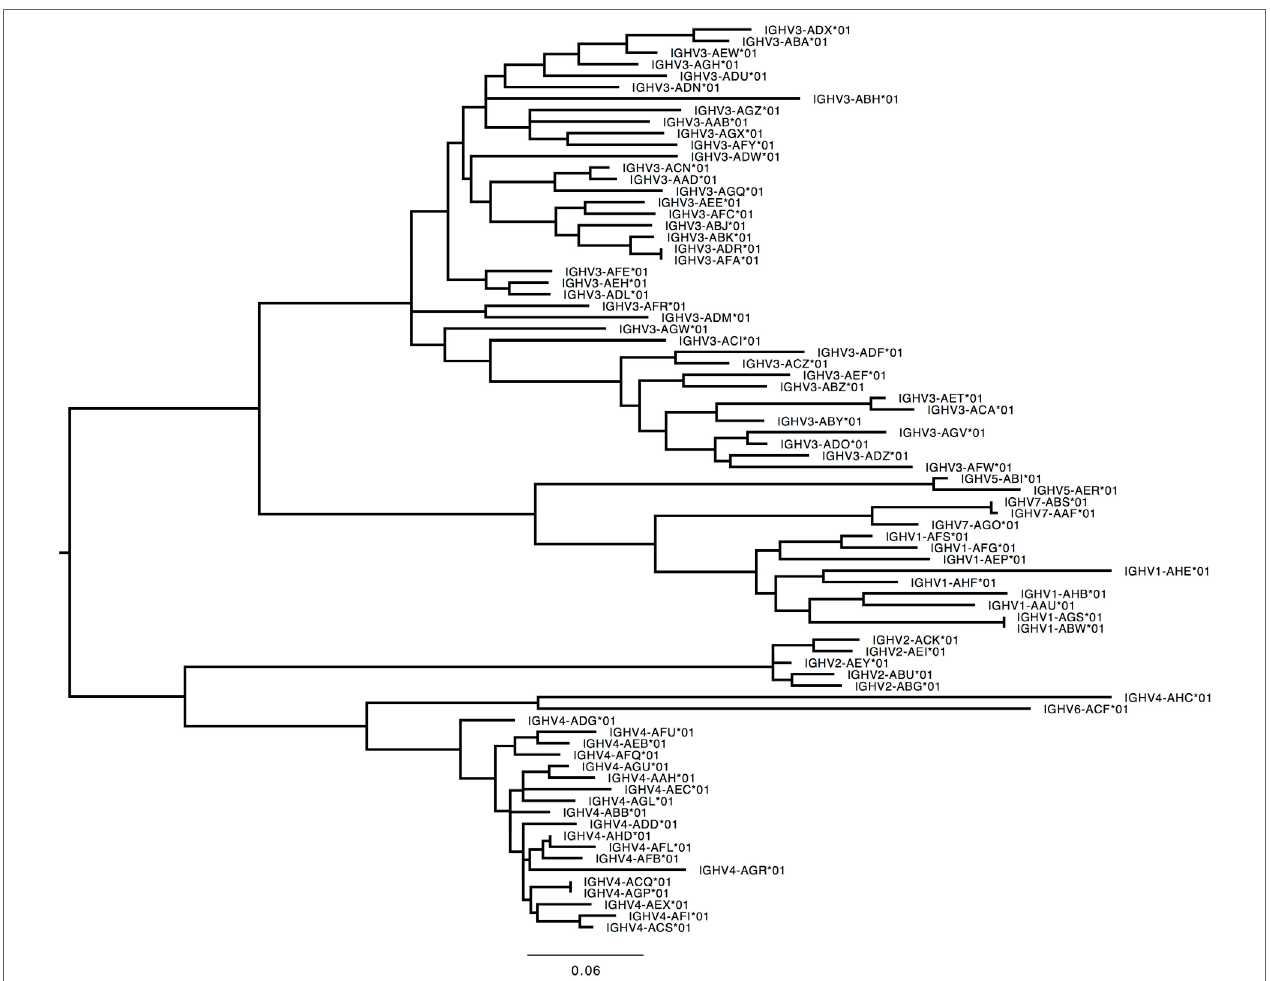
FigUre 4 | Maximum likelihood phylogenetic tree of the rhesus IGHV functional genes, based on the final immunoglobulin allele library.